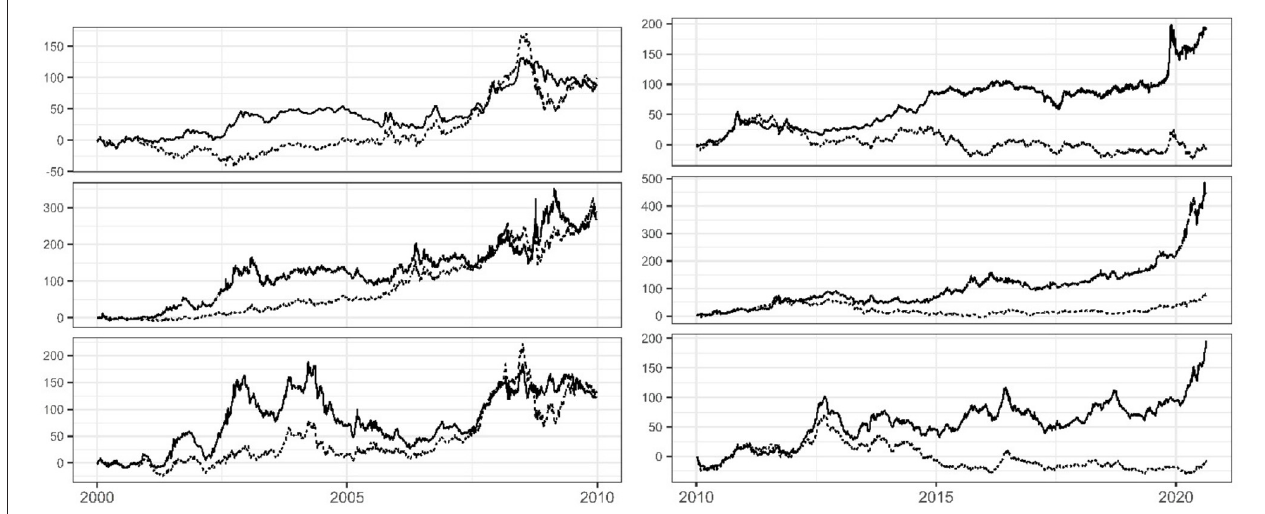
FIGURE 2 | Percent change in prices for beef (top), gold (middle) and soybeans (bottom), in reais and dollars (dashed lines) between 2000 and 2010 (at left), and 2010 and 2020 (at right). The weakening of the real in the early 2000’s (2002–2004) and late 2010’s (post-2015) led to a decoupling between prices in dollars and reais. The decouplings observed between 2002 and 2004 and since 2015 have corresponded with increasing rates of forest loss. Author’s calculations. Data from FRED (2020a,b) and CEPEA/ESALQ